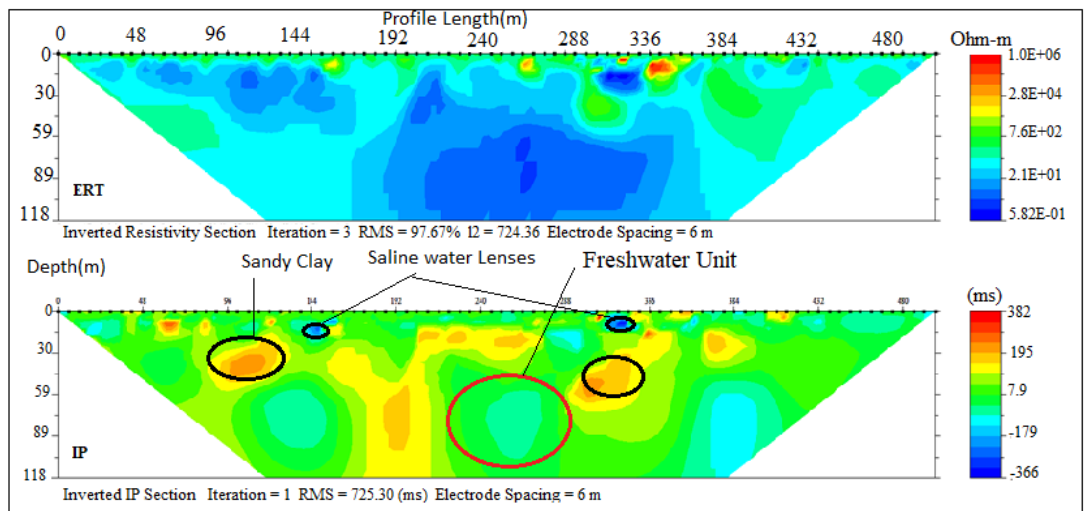
Figure 5. Inverted resistivity and IP cross-sections Aboto (Profile section P2).